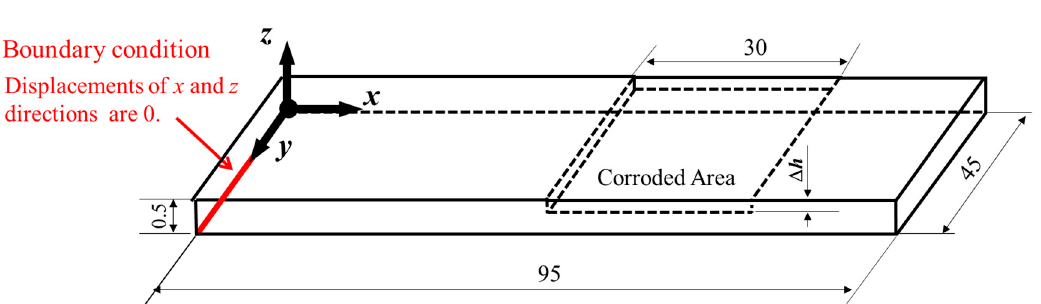
Figure 5. Model of the test piece and boundary conditions used in simulation. The unit is in mm.